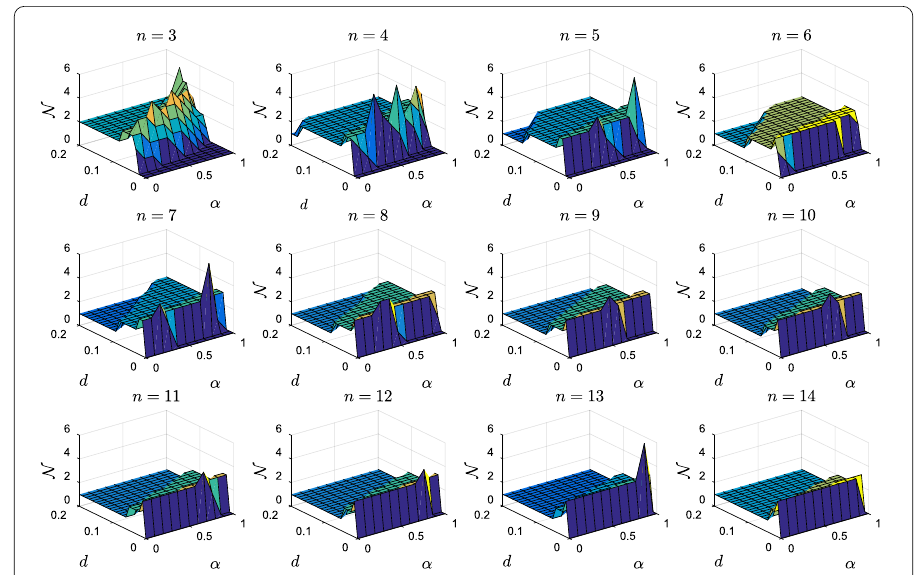
Figure 6 The number of stability intervals N against α , d and n for the fully connected patch model in [18]. The parameter values are κ = 2, μ = 0.2, ε = 1, γ =